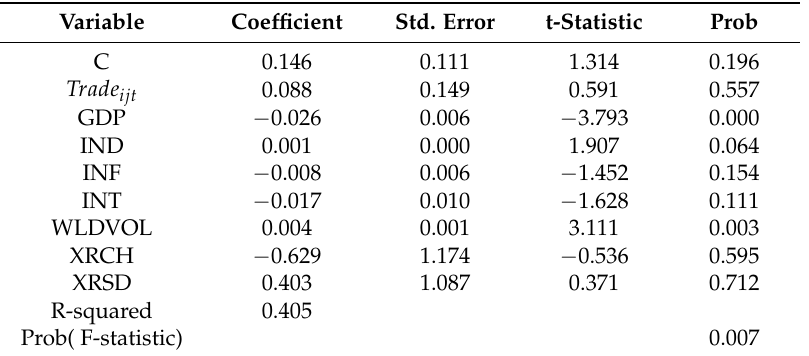
Table 10. Determinant of Stock Market Co-movement between Pakistan and Thailand.